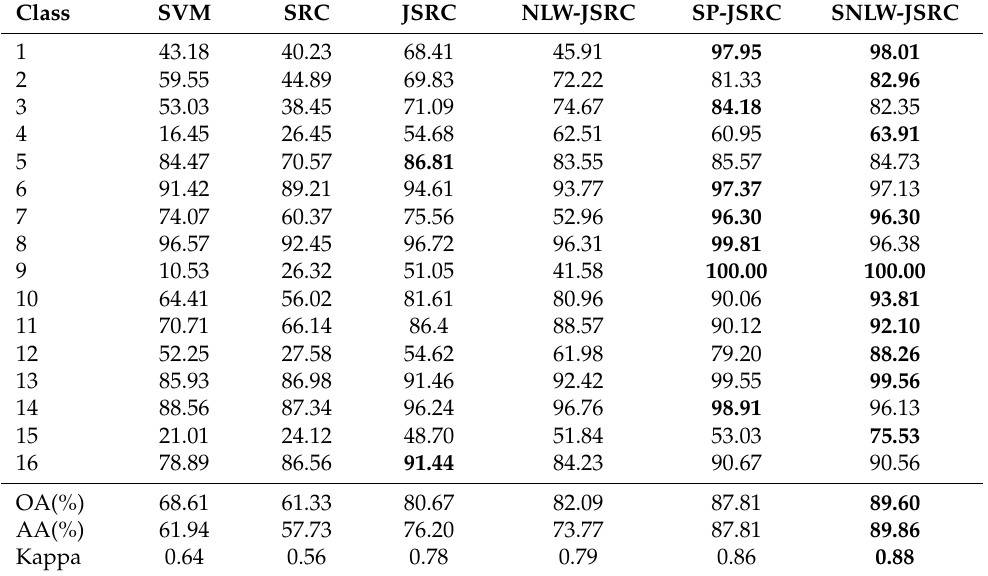
Table 2. Accuracy of Indian Pines classification results (the best result in each row is highlighted in